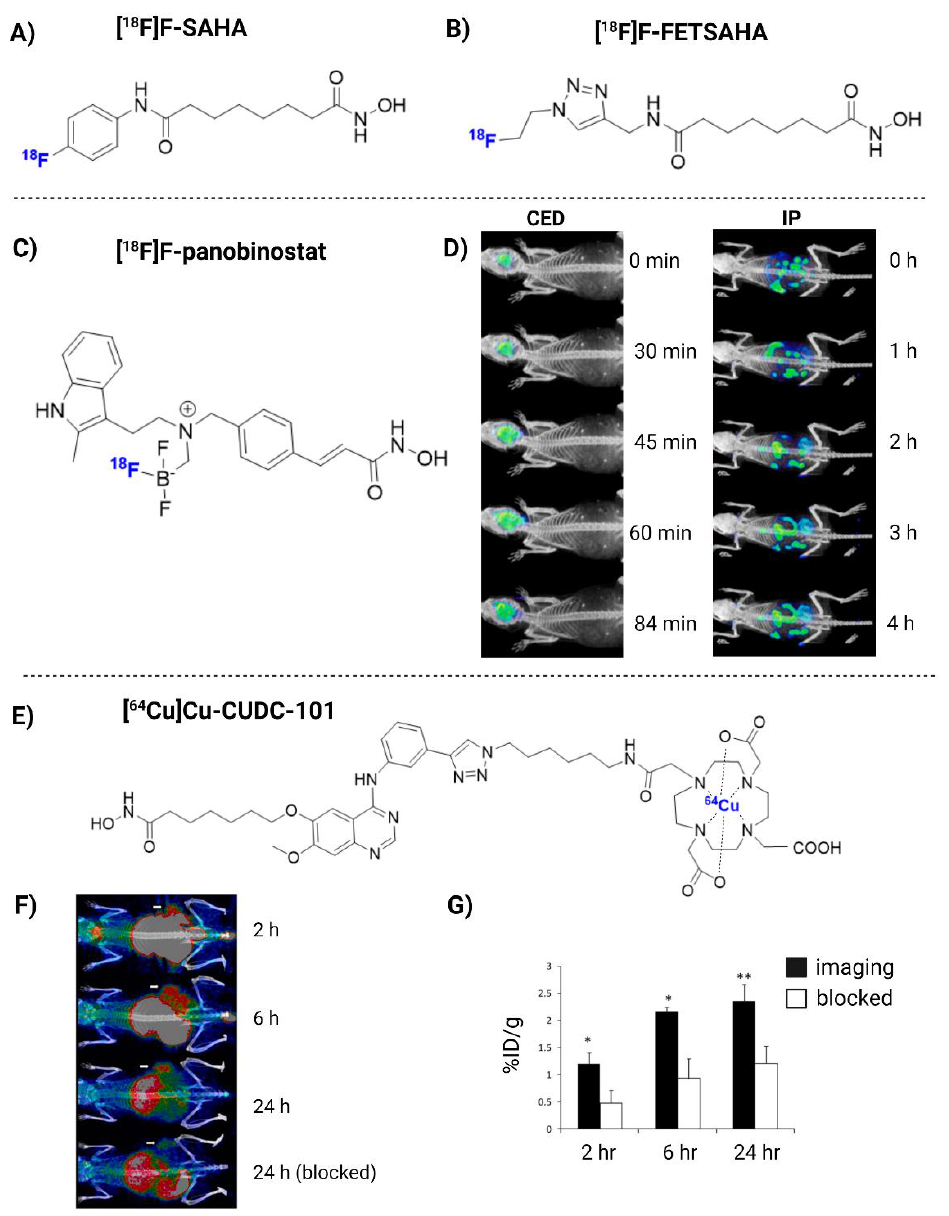
Figure 3. The chemical structure of [ 18 F]F-SAHA ( A ), [ 18 F]FET-SAHA ( B ), [ 18 F]F-panobinostat ( C ) and [ 64 Cu]Cu-CUDC-101 ( E ). [ 18 F]F-panobinostat PET imaging when delivered via convection-enhanced delivery (CED) or intraperitoneal (IP) ( D ). In vivo PET imaging of [ 64 Cu]Cu-CUDC-101 in MDA-MB-231-bearing tumor mice, with or without co-injection of cold CUDC-101 ( F , G ). Images reproduced with permission from [120,124] . Copyright 2013 and 2018 American Chemical Society. As the development of highly brain-penetrant HDACi has been a persistent chal- lenge, research is now shifting from radiolabeling existing HDACi to the development of novel brain-penetrant radiotracers; in particular, adamantane-conjugated radioligands seem promising [104]. The most advanced candidate is (E)-3-(4-((((3r,5r,7r)-adamantan-1- ylmethyl)([ 11 C]methyl)amino)methyl)phenyl)- N -hydroxyacrylamide ([ 11 C]martinostat), an adamantane-based hydroxamic acid with selective binding to HDAC 1, 2, 3 and 6 with subnanomolar potency and fast-binding kinetics [125]. In vivo, [ 11 C]C-martinostat has shown a selective, reversible and dose-dependent binding, excellent signal-to-noise ratio and desirable safety profiles in rodents, pigs and humans [125-127]. Next, an 18 F-labeled